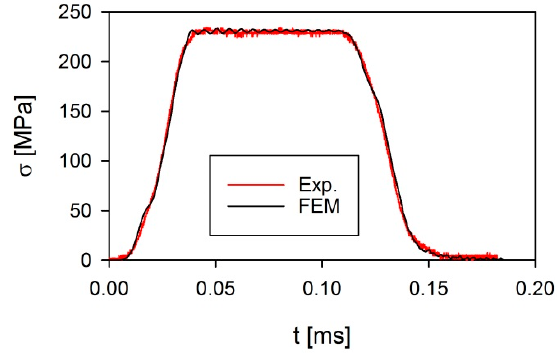
Figure 5. A comparison of the incident wave profiles obtained from numerical (FEM) and experimental (Exp.) analysis; striker velocity 11.76 m/s, copper shaper h = 0.201 mm and φ = 3 mm [14].